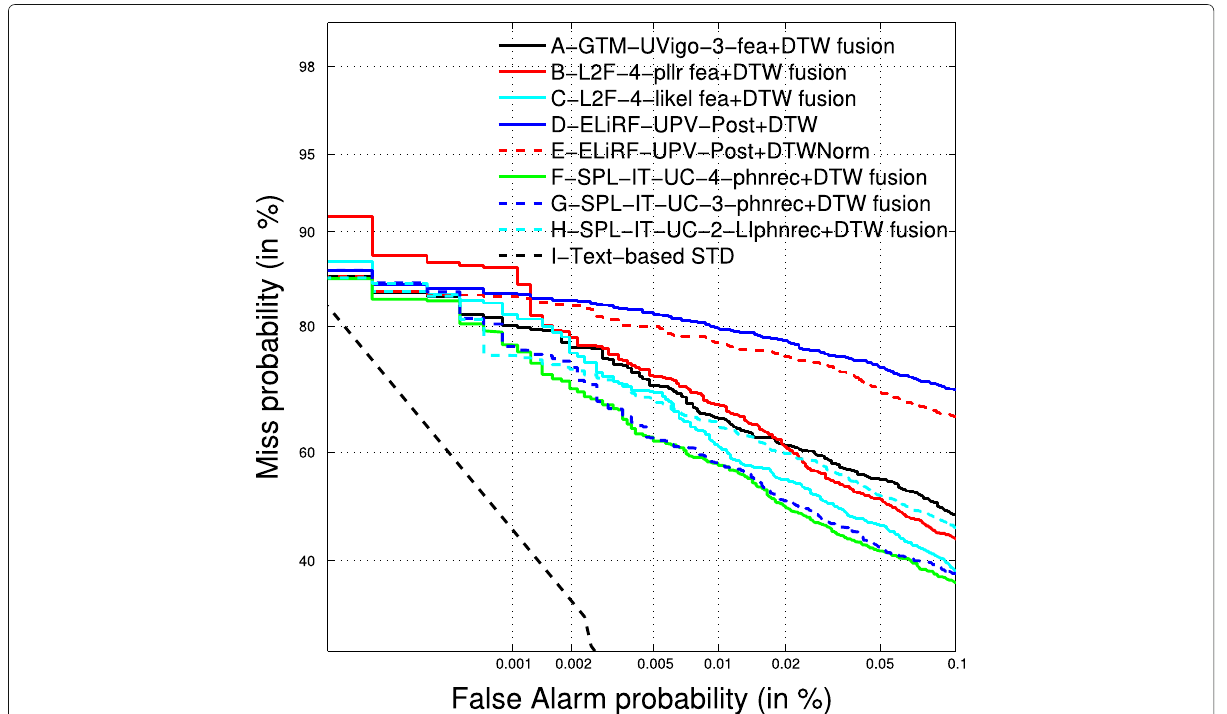
Fig. 8 DET curves of the QbE STD and the text-based STD systems on the EPIC test